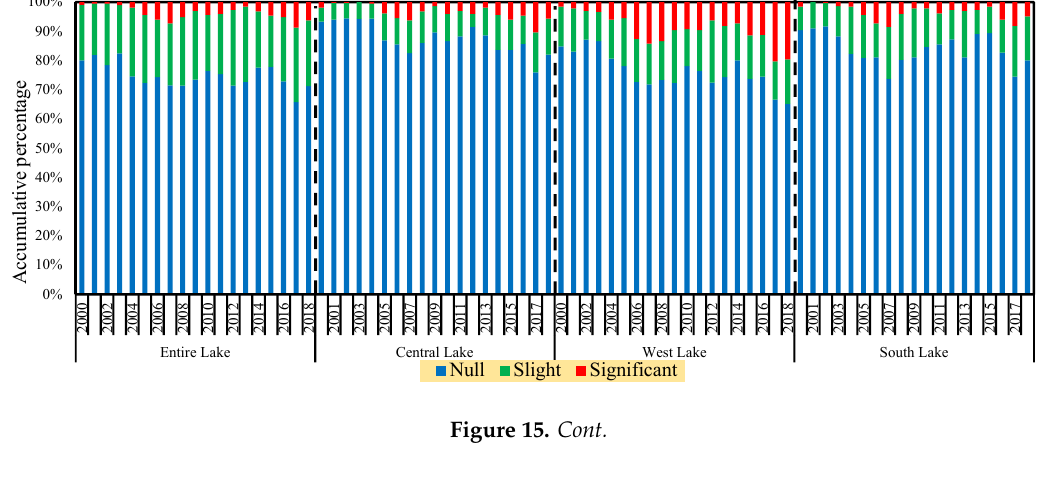
Figure 14. Timing and duration of significant cyanobacteria blooms for the entire lake (excluding East Bay) and each segment.